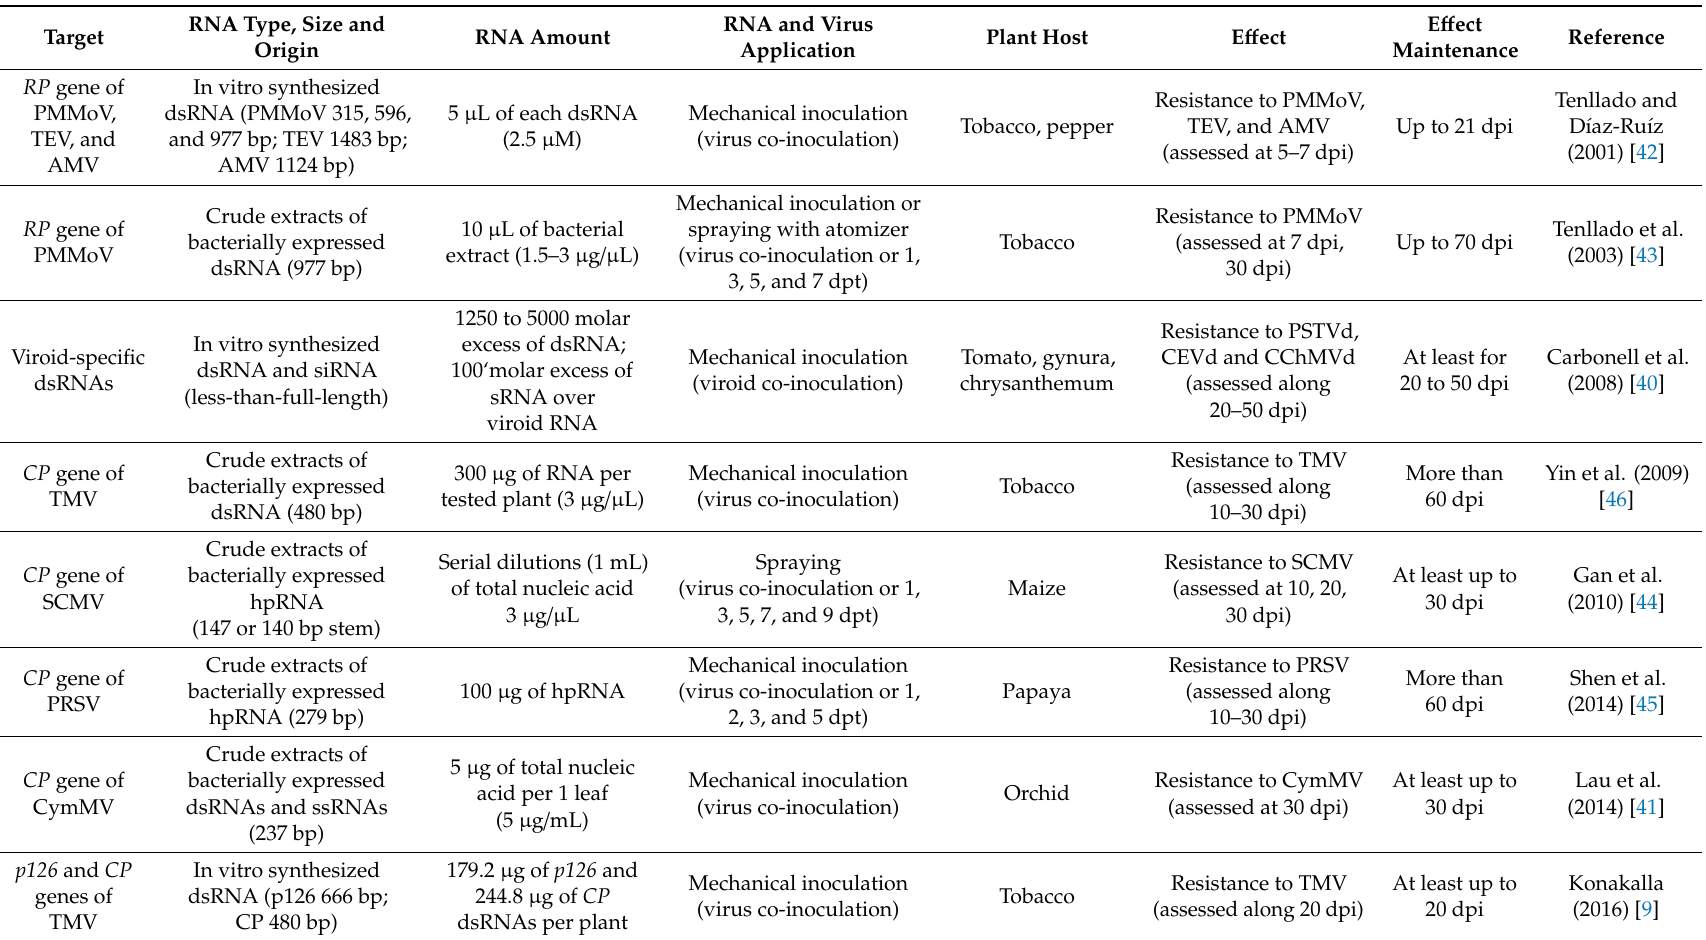
Table 1. Foliar application of RNAs for plant virus